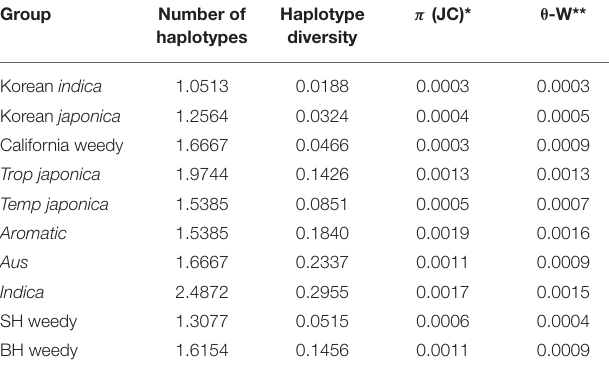
TABLE 2 | Diversity Statistics Averaged Across 41 Sequence Tagged